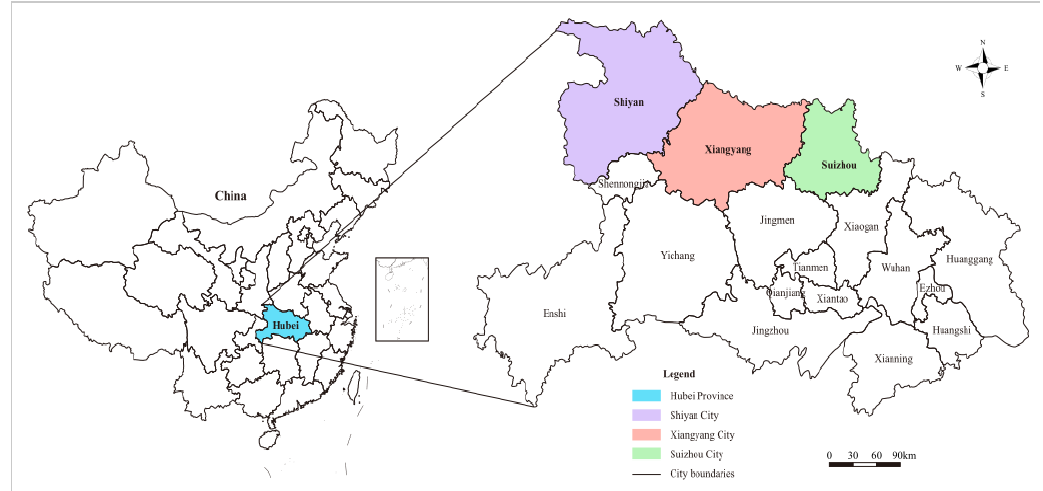
Figure 1. The study area covers parts of Hubei Province in China. Colored areas show the studied cities.